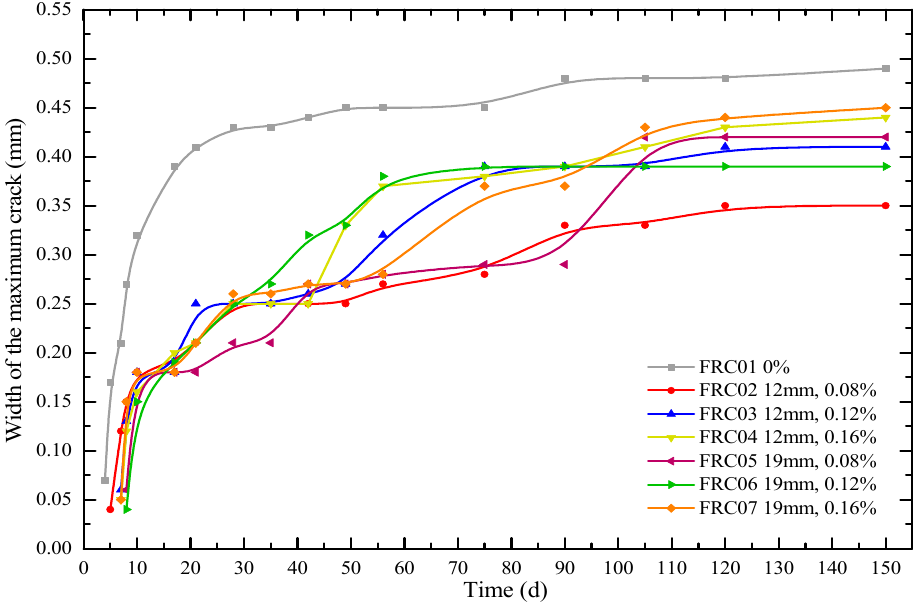
Figure 15. Width of the maximum crack in the concrete specimens during 150 days.